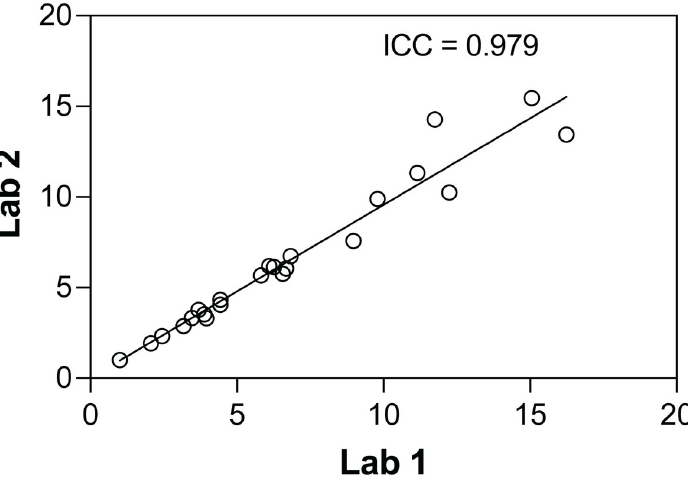
Fig 3. Intraclass correlation of the γ -H2AX expression analyzed by flow cytometry from two different laboratories. The relative MFI results over the dose range from 0 to 6 Gy show the ICC of 0.979 (95% CI, 0.955, 0.990) (n = 6).